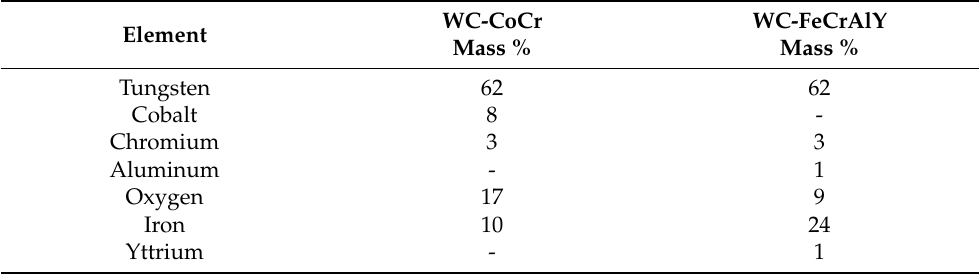
Table 8. EDXS analysis of the particles that are shown in Figure 14 at the regions that are marked by ‘1’.